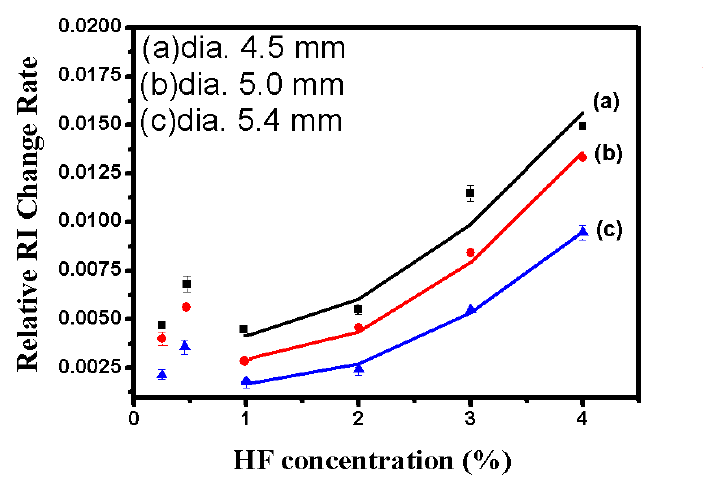
Figure 13. The comparison of relative RI change rates of SiO various-diameter SiO bulks (4.5 mm, 5.0 mm, and 5.4 mm) to detect the HF solutions in 2 different concentrations (0.25%, 0.5%, 1.0%, 2.0%, 3.0%, and 4.0%). The formation of SiO bulk was at R = 10, pH = 4, after standing for 3 2